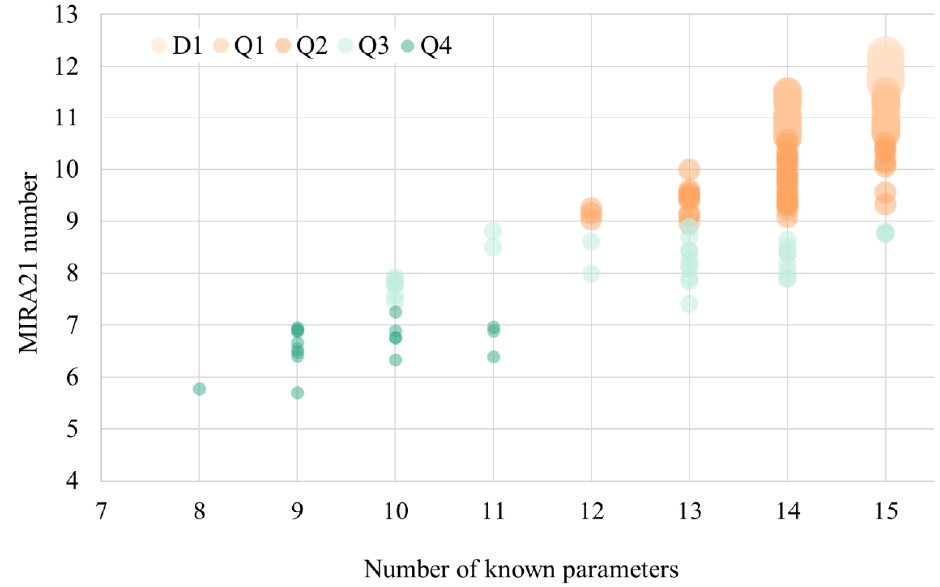
Figure 10. Effect of increasing number of known parameters for MIRA number.